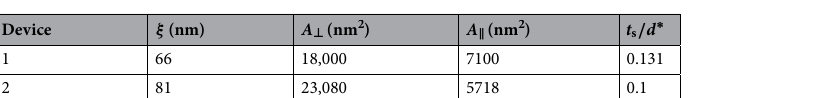
Figure 2. Evidence for single hollow superconducting cylinder behavior and asymmetric Little–Parks effect in the non-destructive regime (Device 1). ( a – e ) Colormaps of differential resistance, dV / dI , versus DC bias current, I , and magnetic field approximately parallel to the axis of the double nanowires, B θ (cid:31) , with a small misalignment angle θ indicated in each plot. A small, constant magnetic field approximately perpendicular to the axis of the double nanowires, B θ ⊥ , misaligned by the same angle θ , was also applied in ( b , c , e ), as indicated in each of these plots. Dashed lines in ( a – e ) are calculations of critical current, I c , using the single hollow superconducting cylinder model. Fit parameters are given in Table 1.